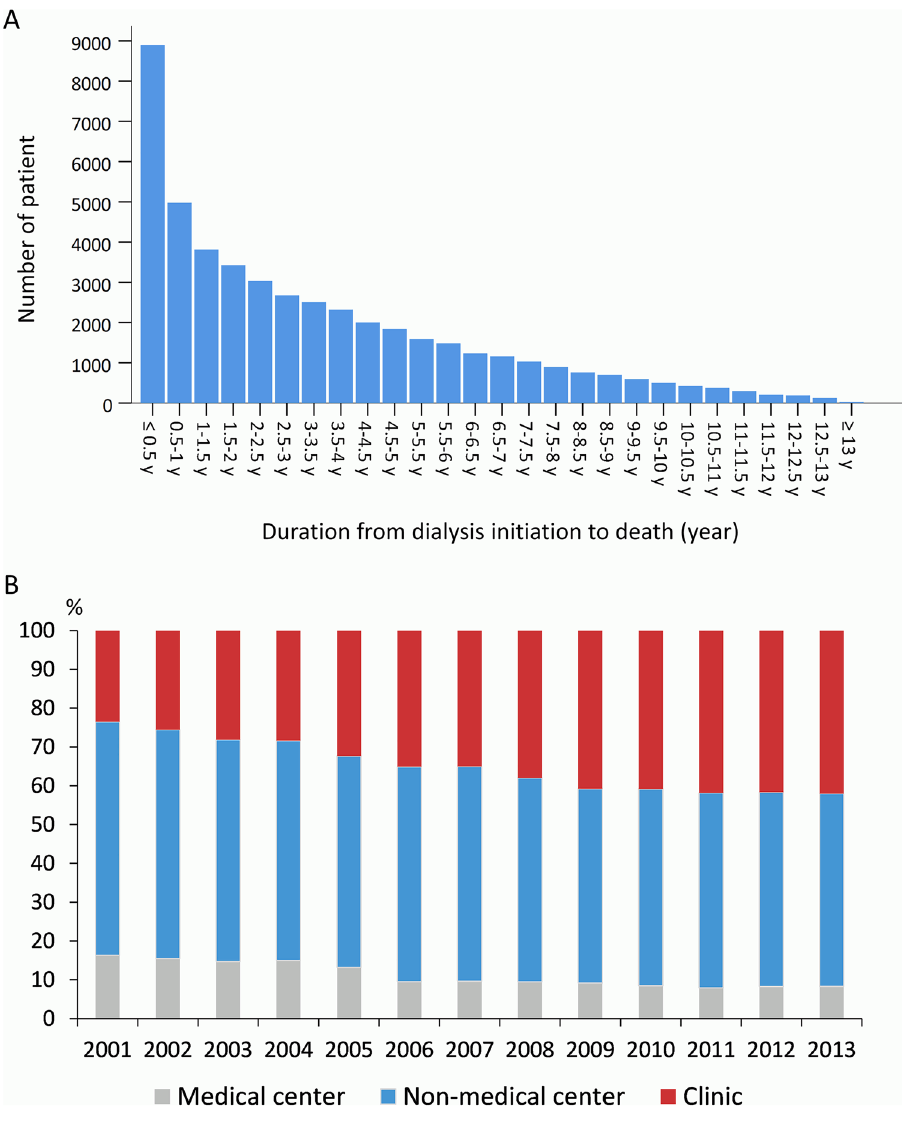
Figure 2. ( A ) Distribution of the duration from dialysis initiation to death and ( B ) the distribution of facility level related to initial hemodialysis during 2001–2013 in